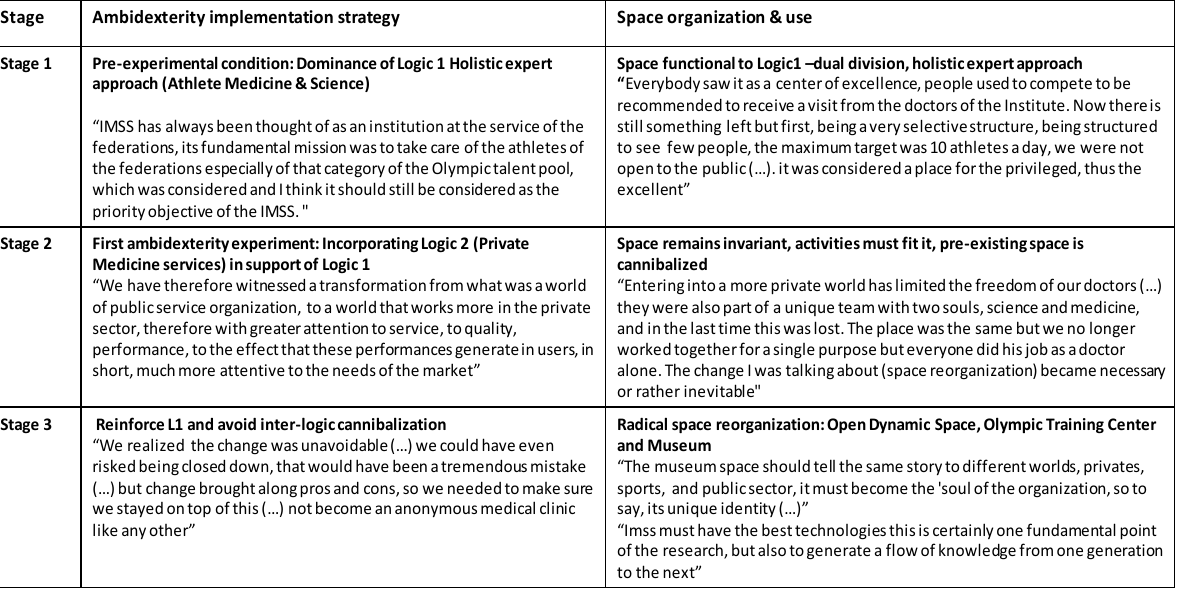
Fig. 2. First ambidexterity experiment: introduction of private medicine services (logic 2) cannibalizes pre-existing space (logic 1) Tab. 1. Interview excerpts exemplifying the process of implementing ambidexterity across three